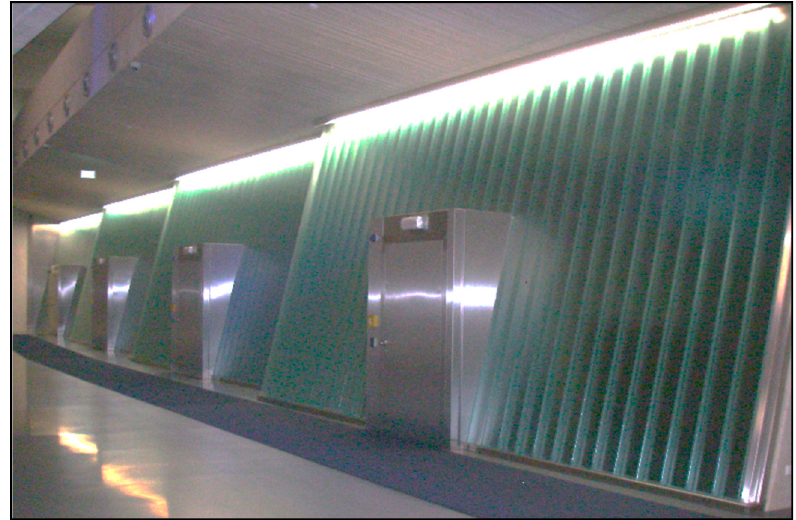
Figure 2. Storage vaults, flanked by “light art”; Luxembourg Freeport (photo by the author).